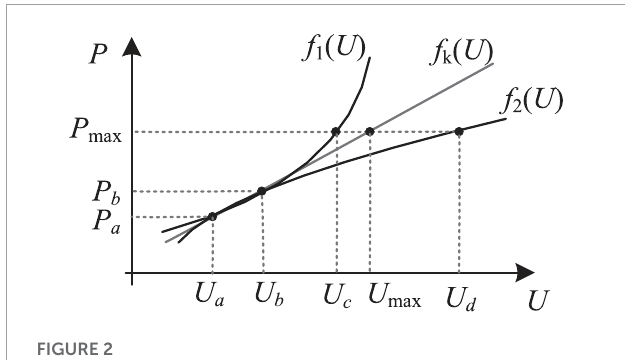
FIGURE 2 The relationship between active power and